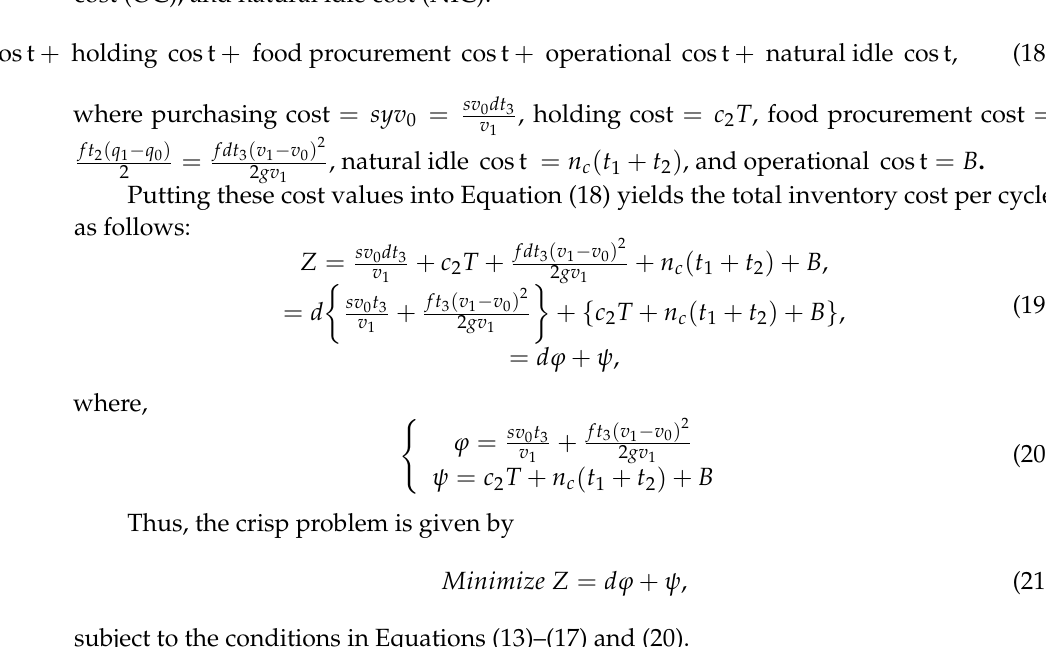
Figure 8. Diagram of the proposed model.